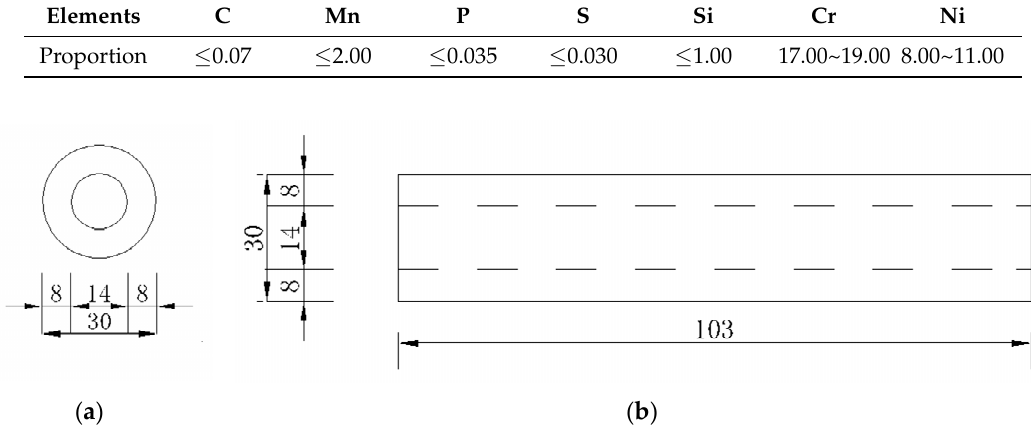
Figure 1. Dimension of pin (mm): ( a ) Side view; ( b ) front Figure 1 . Dimension of pin (mm): ( a ) Side view; ( b ) front view.